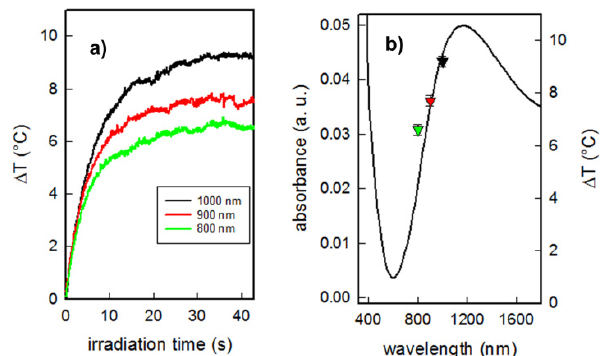
Figure 4. ( a ) Temperature increase as a function of irradiation time, measured under NIR laser irradiation at different wavelengths (800–1000 nm, 0.26 W/cm 2 ) of Cu NP-glass samples; ( b ) photo-thermal effect as increase of temperature (right axe) of Cu NP-glass samples, as a function of irradiation wavelength (each color of point corresponds to a wavelength as in panel (a)), superimposed to spectrum of the functionalized glass sample.